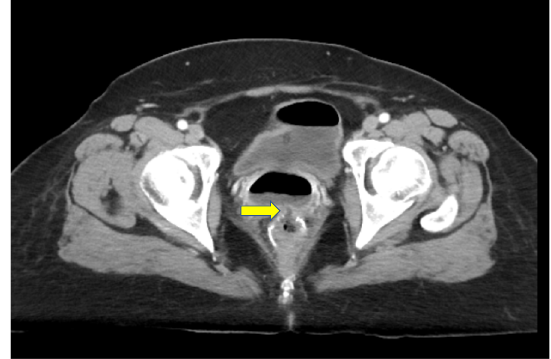
Fig. 2 Computed tomography scan revealed a fistula between the vagina and the rectum